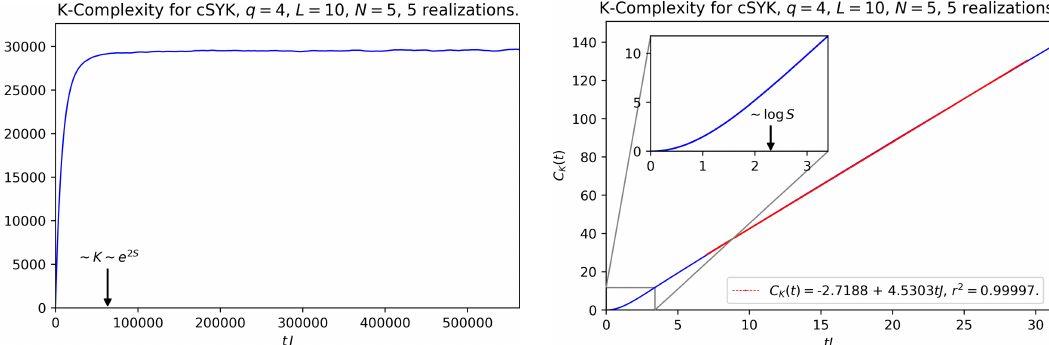
Figure 2 . K-complexity averaged over 5 random realizations with L = 10 sites at half filling. Left: full time range computed. Saturation occurs at time scales of order t 2 S with value near K ∼ K ∼ e K/ 2 = 31626 . 5 (this is the time scale at which the wave-packet ϕ n ( t ) , which propagates at roughly constant — but slowly decreasing — velocity, reaches the edge of the Krylov chain). Right: zoom in at early times. Note the initial non-linear growth transforming into linear growth, as verified by the linear fit (in red). Relevant time scales are indicated in the plots, although their exact location may depend on a dimensionful prefactor (the Lyapunov exponent, as discussed in